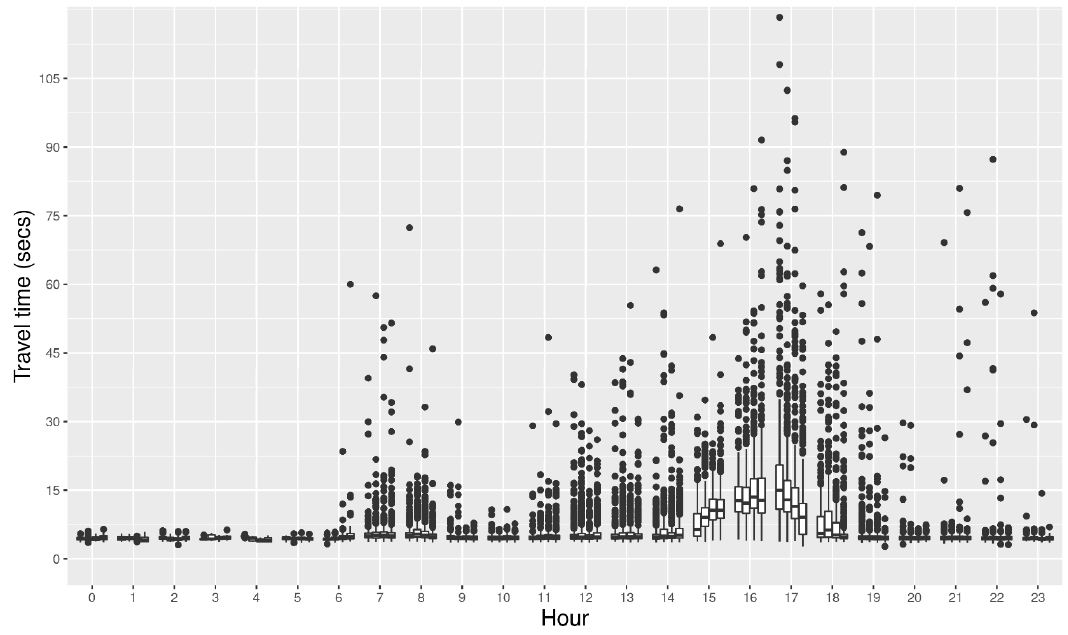
Figure 4. Travel time boxplots as a function of time of the day observed on osm_id 283052776 (fraction start-end: 0.35–0.51) (Aut.Félix-Leclerc (40) east, Quebec City).